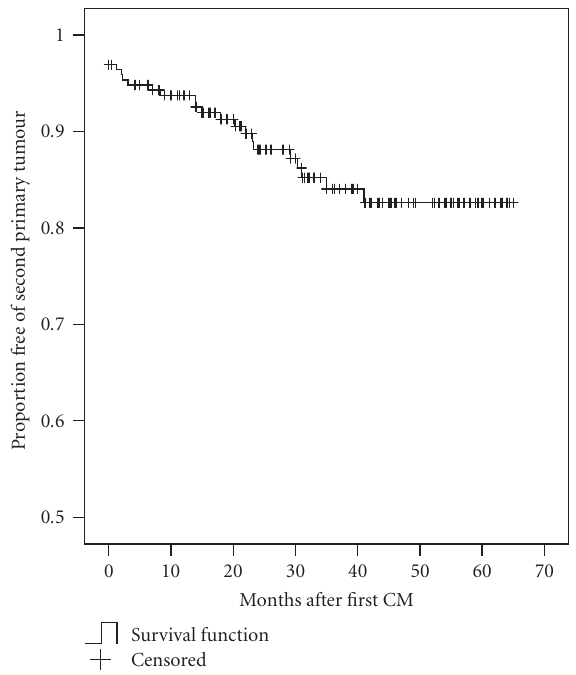
Figure 3: Actuarial survival curve representing the probability of a second primary tumour (cutaneous and noncutaneous) in monthly intervals in the study